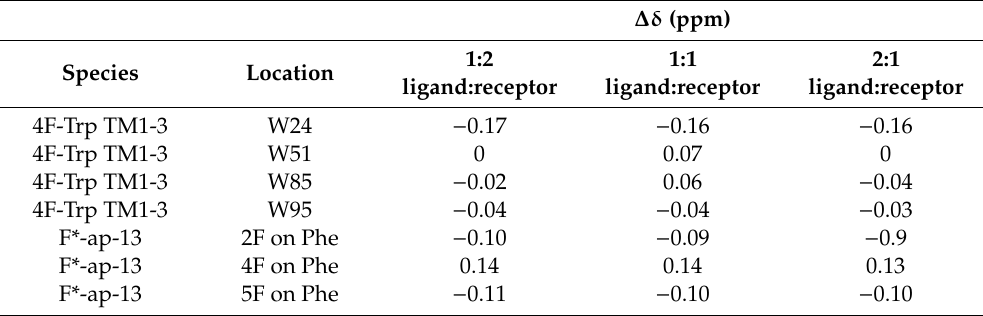
Table 2. 19 F chemical shift perturbation ( ∆ δ ) relative to control sample in absence of binding partner for TM1-3:F*-ap-13 interactions.